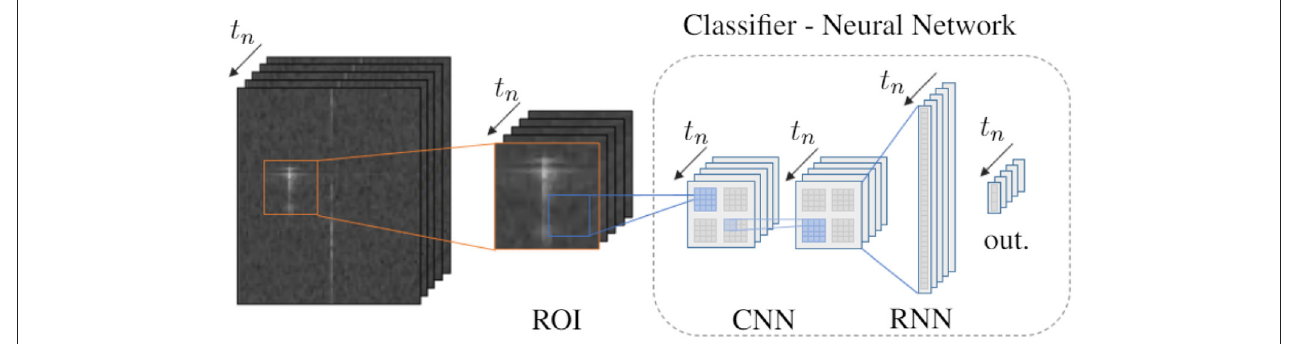
FIGURE 8 | Approach and network architecture for radar object classification: From range-Doppler maps region of interests (ROIs) around detected objects are extracted and injected into a classifier neural network over discrete time steps t n . The network consists of two 2D convolutional layers, a recurrent layer and an output layer. Both ANN and SNN variants are compared, see main text for details.